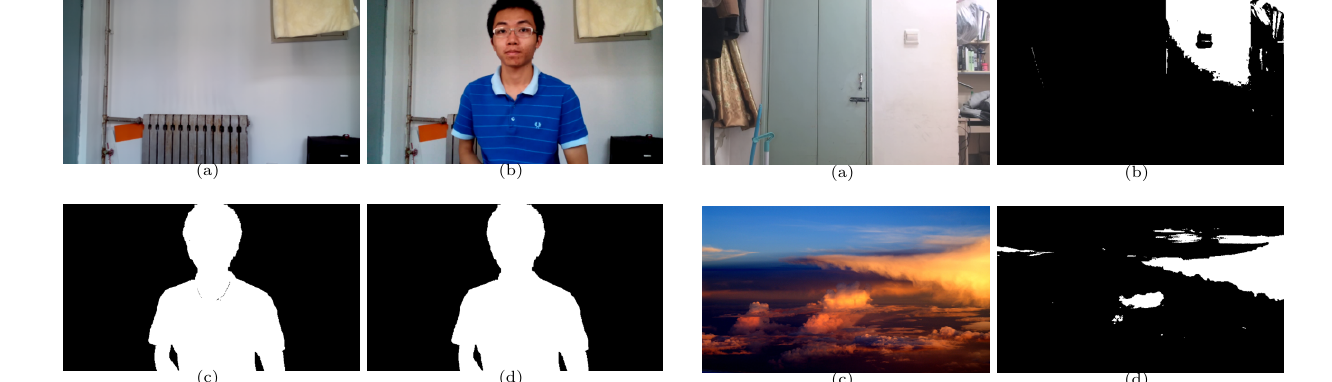
Fig. 3 (a) Pre-captured background. (b) Estimated light source mask of the pre-captured background (a). (c) New background. (d) Estimated light source mask of the new background